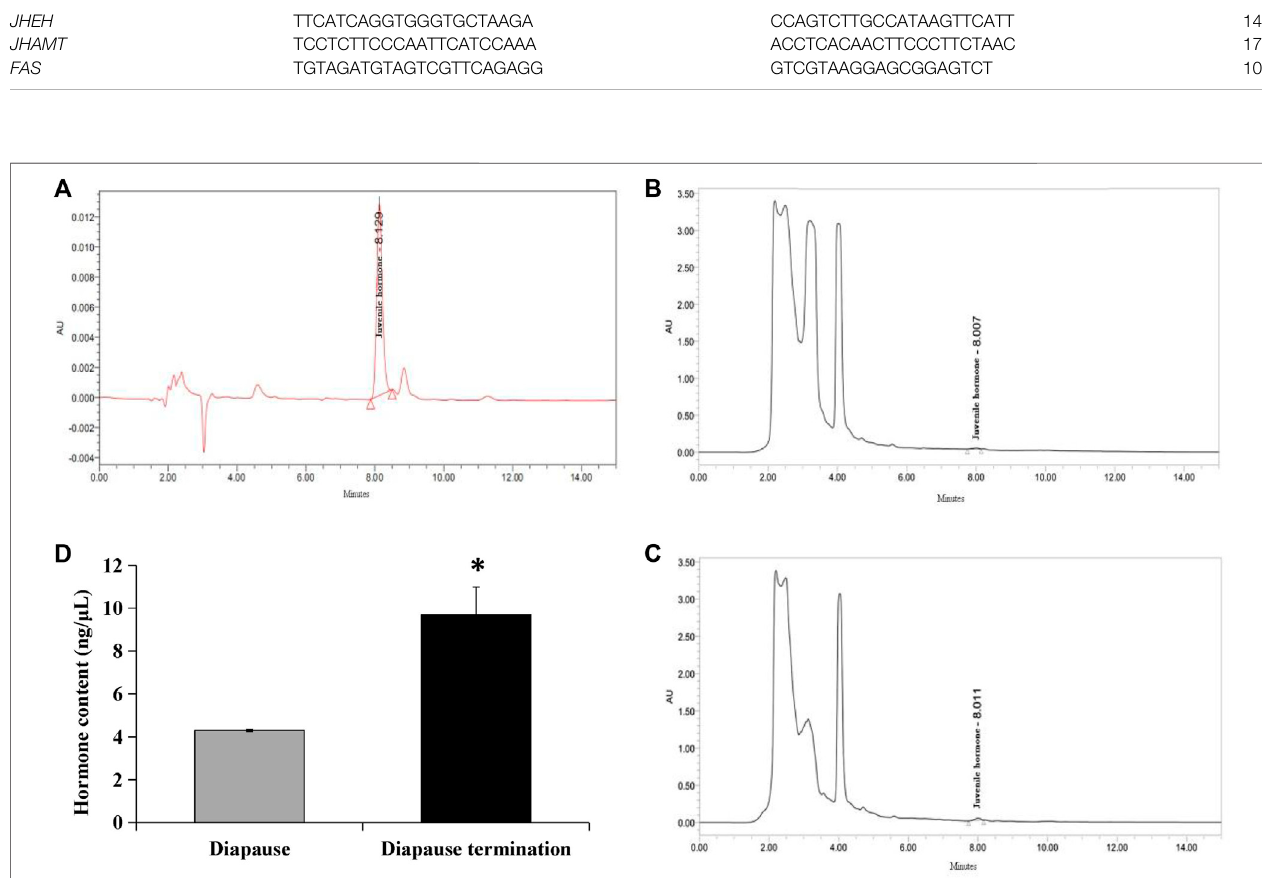
FIGURE 1| Determination of JH Ⅲ in diapauseand diapause termination adult individuals. (A) Chromatogram ofJHIII standard sample. (B) Chromatogram of JHIII indiapauseof A.chinensis. (C) ChromatogramofJHIIIindiapauseterminationof A.chinensis. (D) Quanti fi cationofJHIIIcontentindiapauseanddiapausetermination.*, p < 0.05 (independent t